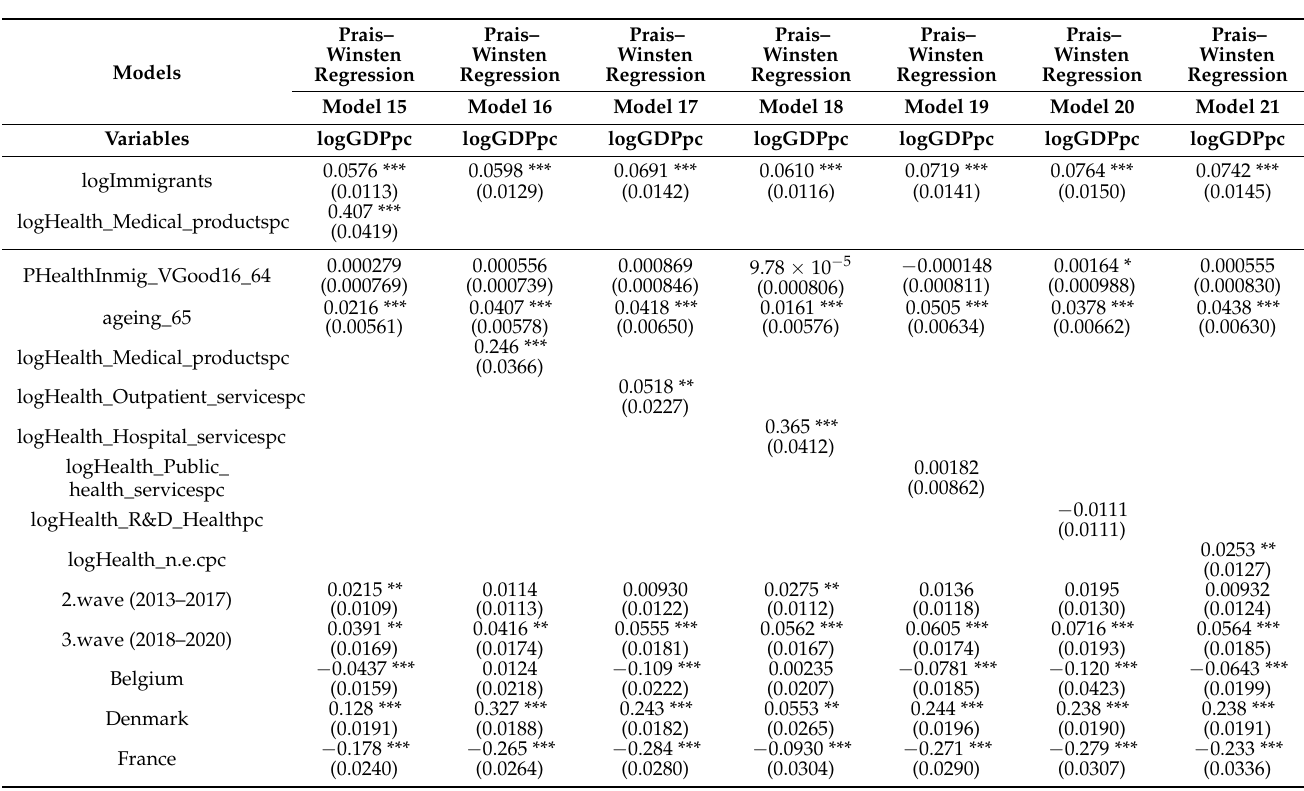
Table 5. Prais–Winsten Regression models with breakdown of public health expenditure by function and